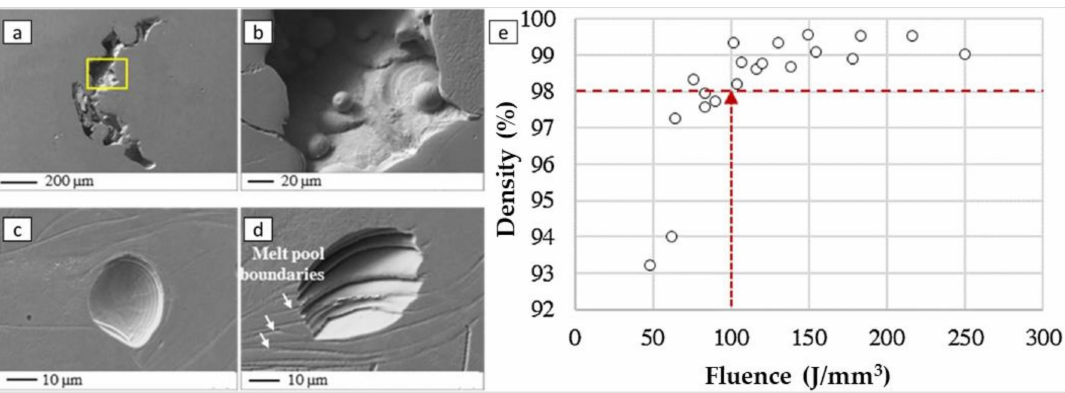
Figure 2. A visual representation of the ( a , b ) binding (as shown in the yellow rectangle) and ( c , d ) porous defects induced from insufficient laser melting for 316L SS. The LED against part density is also shown ( e ) [38] Copyright 2022